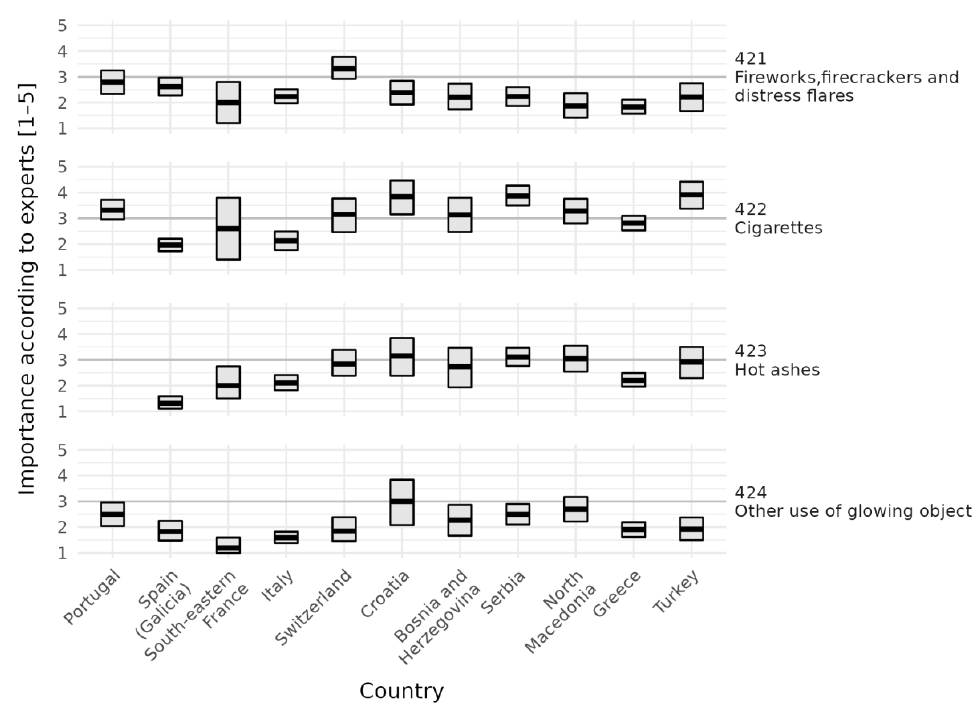
8 Figure 8. Crossbar plot of the importance of ignition due to Negligent use of glowing objects , according to the smean.cl.boot function from the Hmisc R-package, grouped by